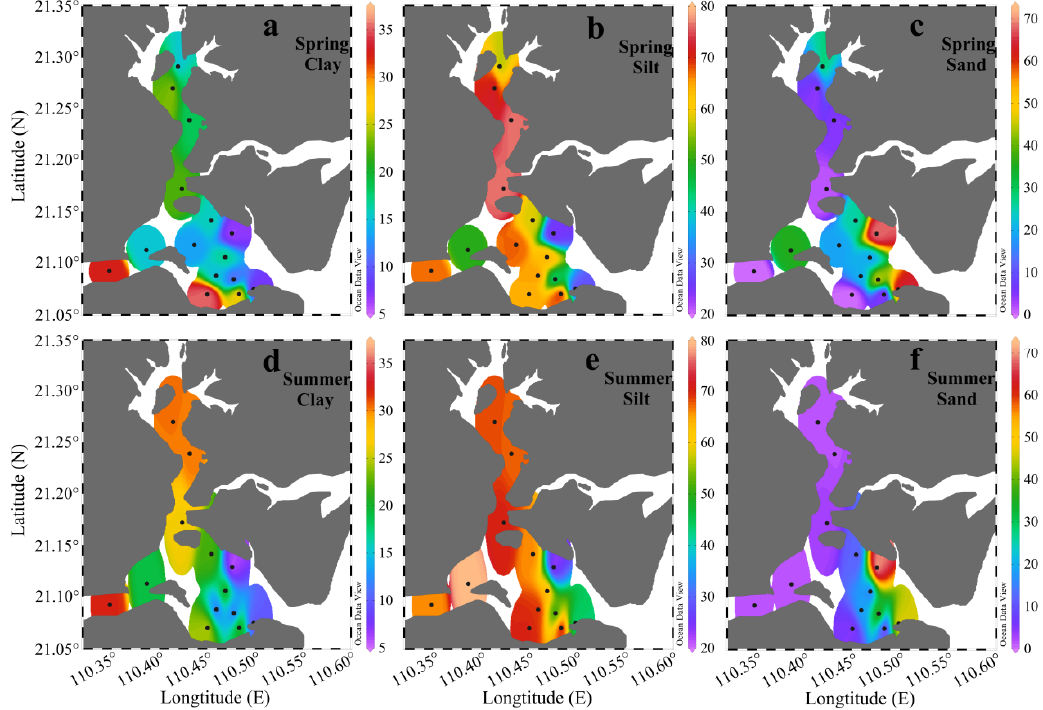
Figure 3. Spatial variations in the clay ( a , d ), silt ( b , e ), and sand ( c , f ) fractions of the surface sediments collected in Zhanjiang Bay in spring and summer (unit: %). Table 2. Mean values (mean ± SD) of the carbon and nitrogen parameters and grain size compositions for the surface sediments in di ff erent subregions of the Zhanjiang Bay. TOC, total organic carbon; TN, total nitrogen; δ 13 C, stable carbon isotope composition; δ 15 N, stable nitrogen isotope